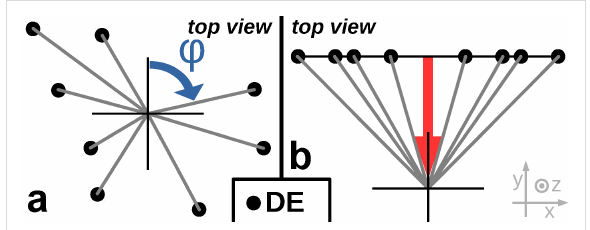
Figure 4: Schematic overview of the angle-sorted proximity avoiding algorithm (asPAA). a: In order to minimize the proximity effect the angle φ between a deposition event’s position (DE) and the center of all DEs of one frame is calculated for every DE. The final order of the DEs of a frame is chosen in order to let the electron beam move as far as possible between the DEs and not let it come back close to the DE for the next but one DE. b: If all DEs are in an area with a too high aspect ratio (e.g., bigger 1:10), like a line, the center of the frame’s writing area is artificially shifted in the shorter direction in order to have other φ than { φ 1 , φ 1 + 180°}, which would produce a quite random